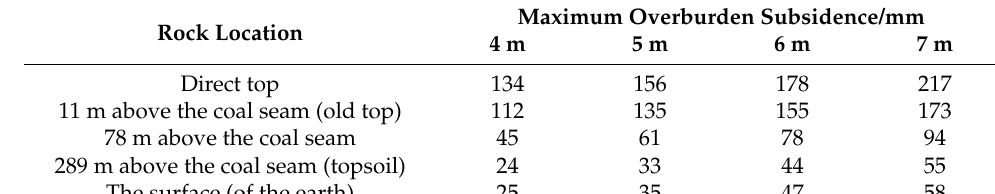
Table 5. Maximum overburden subsidence for different mining width conditions. Rock Location